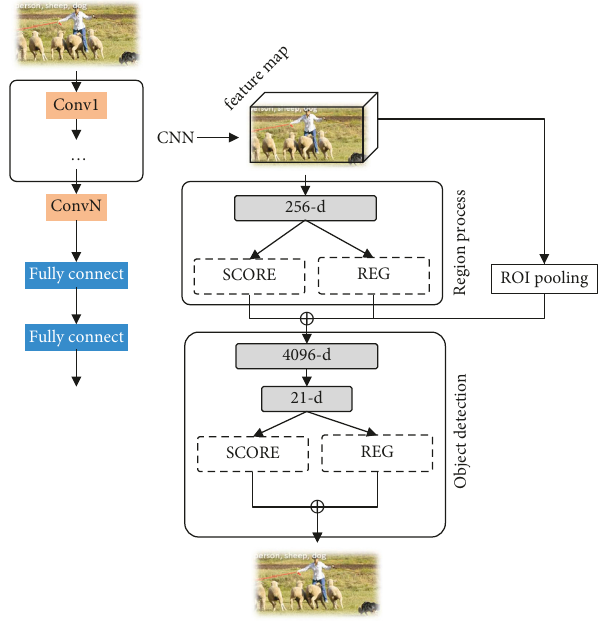
Figure 7: Principle of